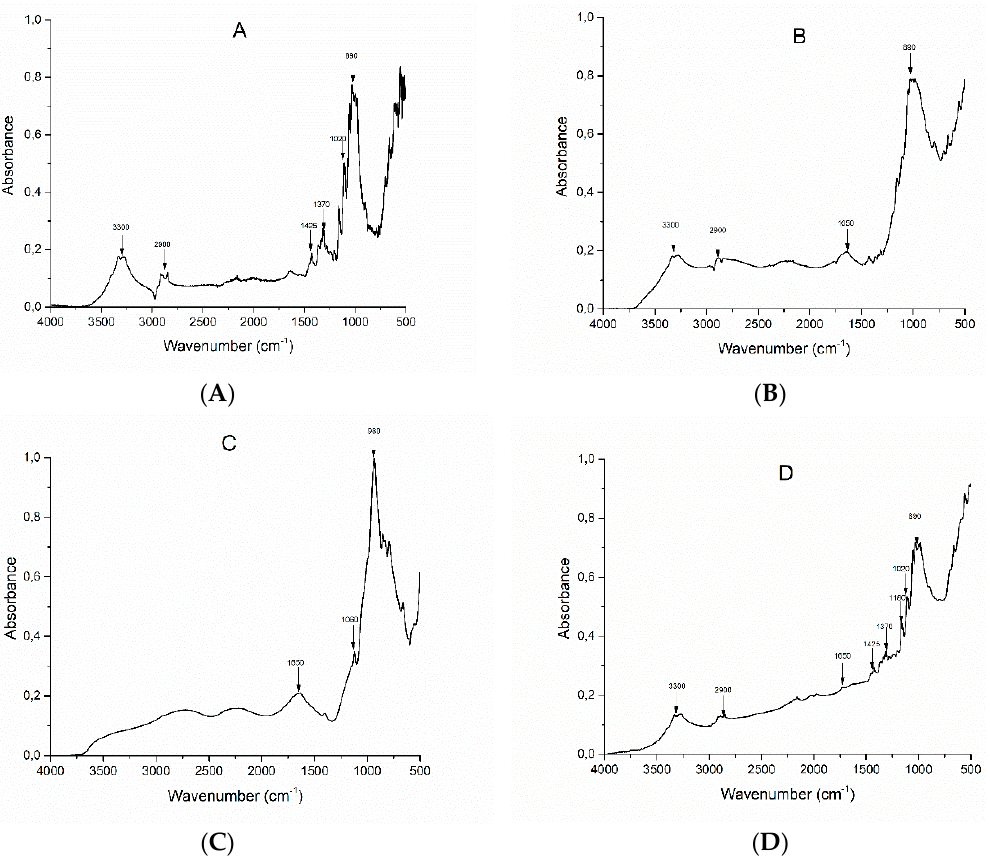
Figure 1. FTIR ‐ attenuated total reflection (ATR) spectra of cotton (COT) (A), cotton+phytic acid Figure 1. FTIR-attenuated total reflection (ATR) spectra of cotton (COT) ( A ), cotton + phytic acid (COT+PA) (B), PA (C) and cotton+phytic acid+biochar (COT+PA+BC(8)). (COT + PA) ( B ), PA ( C ) and cotton + phytic acid + biochar (COT + PA + BC(8)) ( D ). Polymers 2020 , 12 , x FOR PEER REVIEW